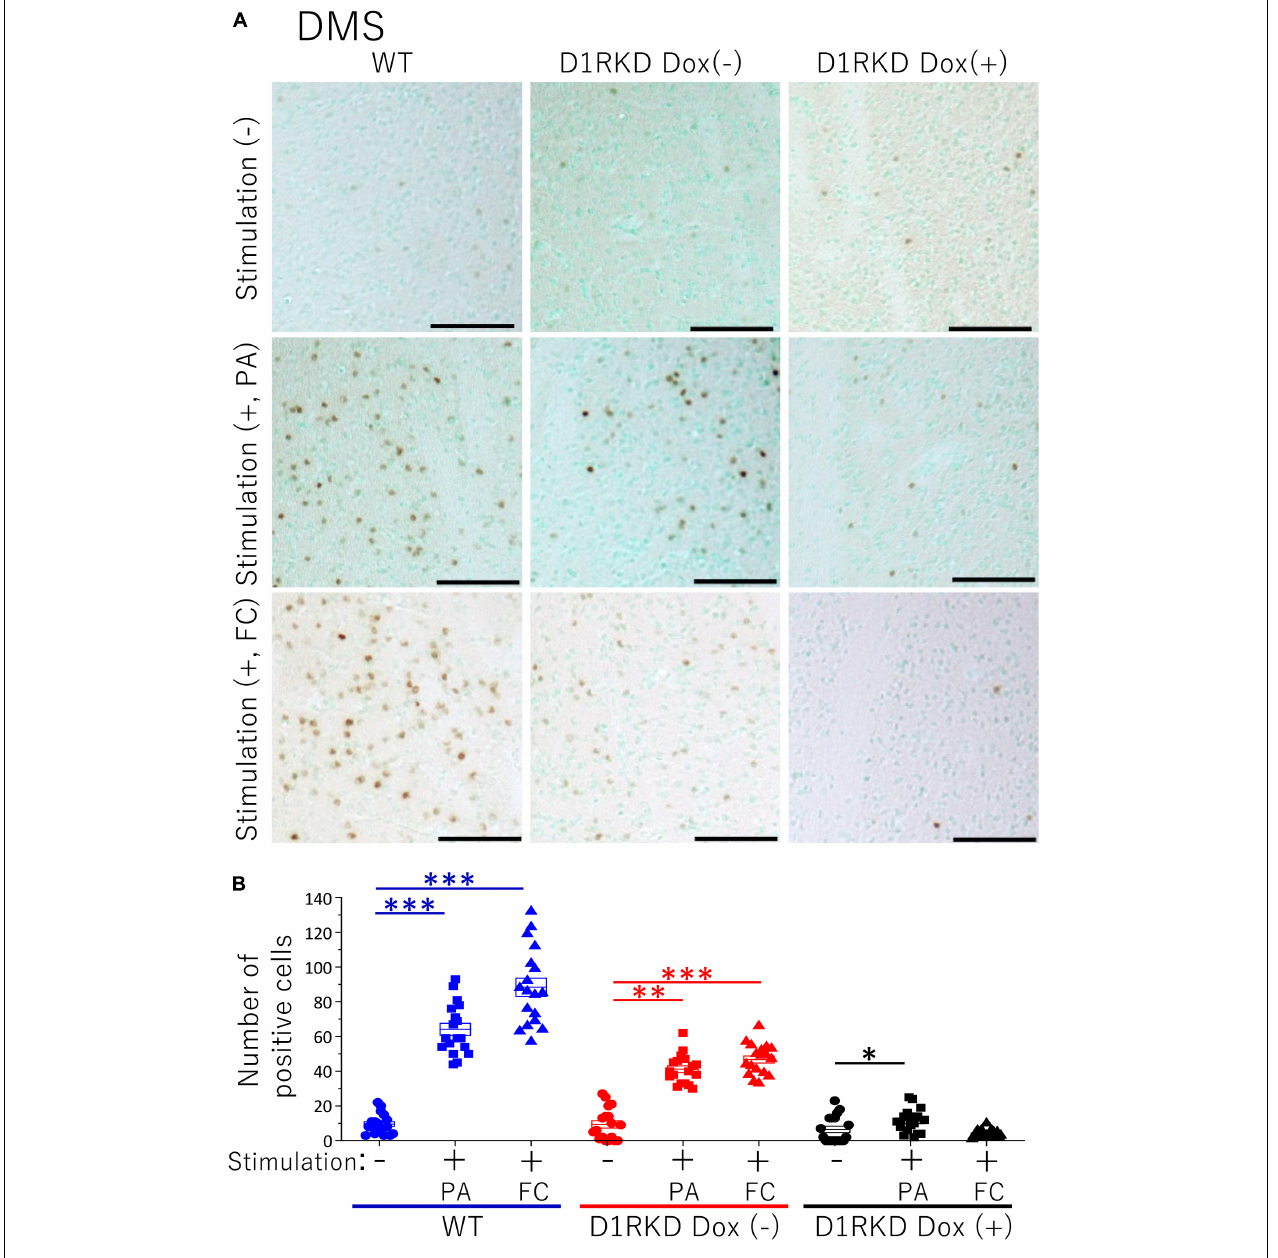
FIGURE 5 | Immunohistochemical analysis of c-Fos expression in DMS after 1 h of electric foot shock stimulus using a step-through-type apparatus for the passive avoidance test (PA) or fear conditioning system (FC). (A) Representative immunohistochemical staining of c-Fos positive cells. Scale bar, 100 µ m. (B) The number of positive cells in DMS in immunohistochemistry. All groups, n = 18. The blue color indicates the values of WT groups, the red color indicates the values of D1RKD Dox (–) groups, and the black color indicates the values of D1RKD Dox (+) groups. The circle, square, and triangle indicate no stimulation, stimulation by PA, and stimulation by FC, respectively, ∗ p < 0.05; ∗∗ p < 0.01; ∗∗∗ p <